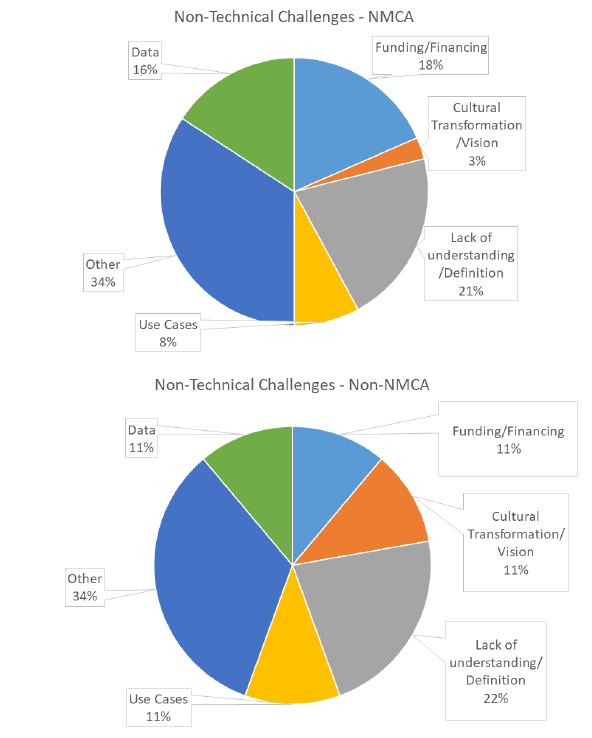
Figure 3: Non-Technical Challenges